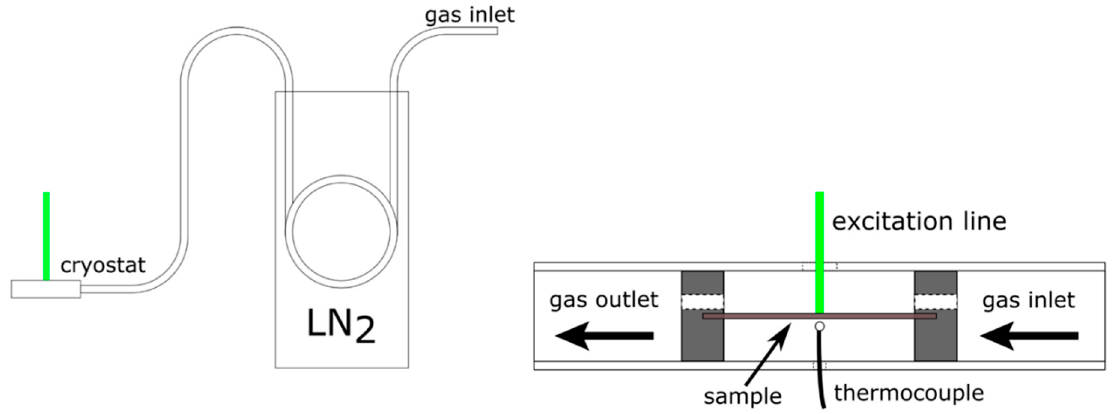
Figure 2. The experimental setup for study of Raman spectrum of KAgF 3 at low temperature.